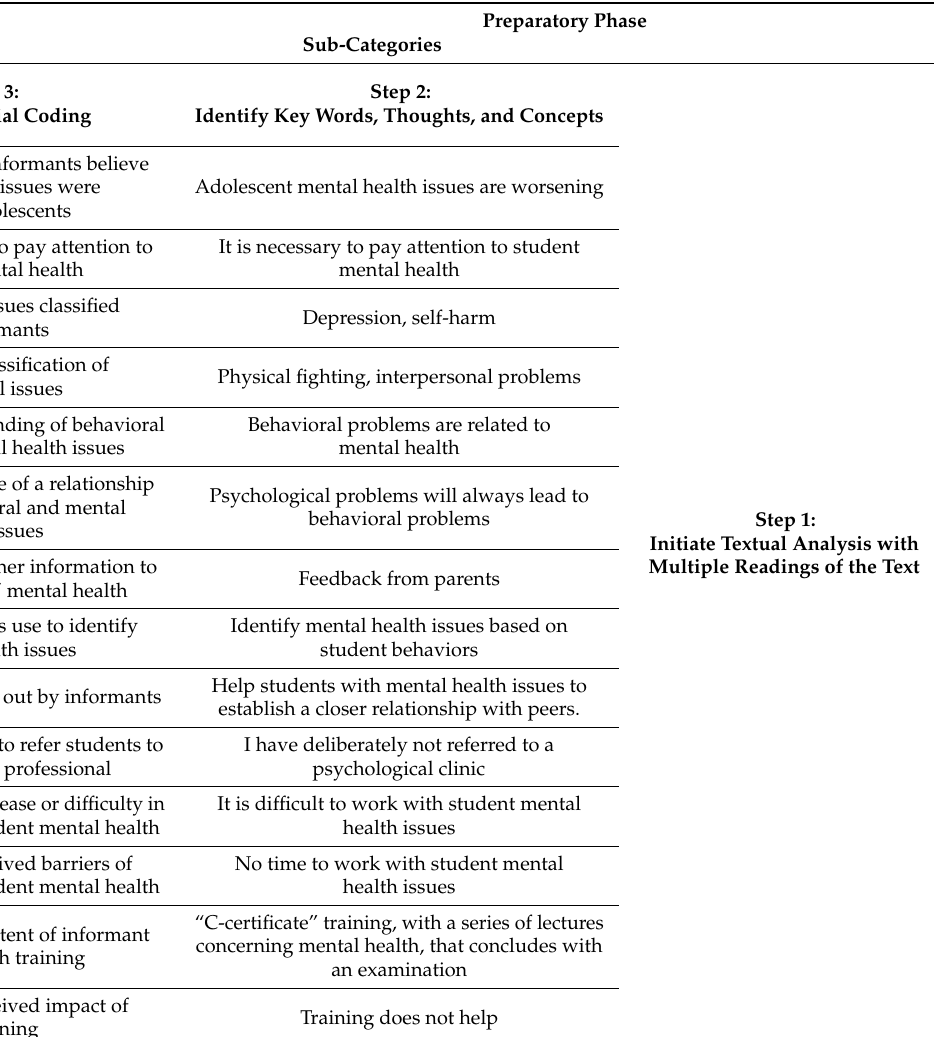
Table 1. Generation of categories and sub-categories from initial coding using content